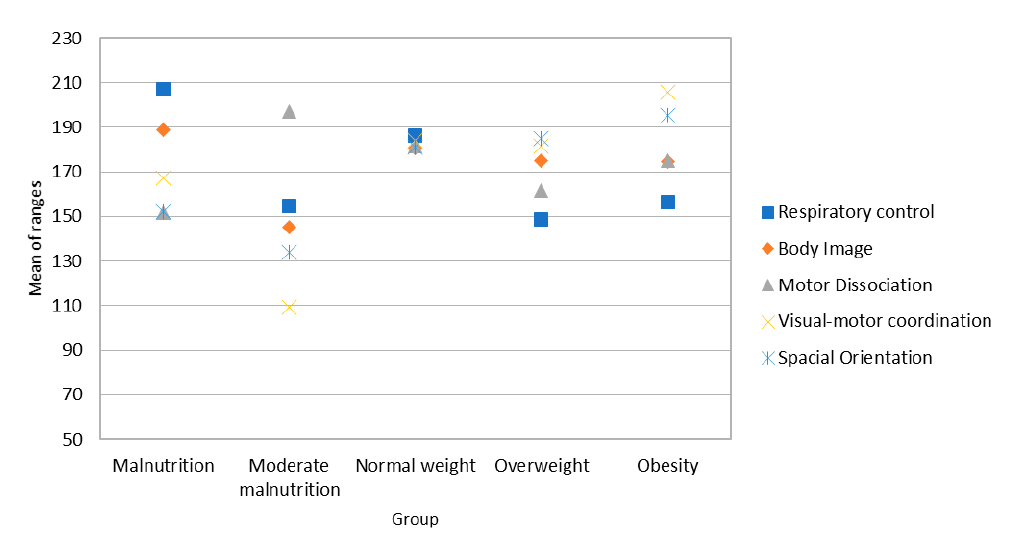
Figure 4. Average range of the scores for perceptual skills in the sample of boys.